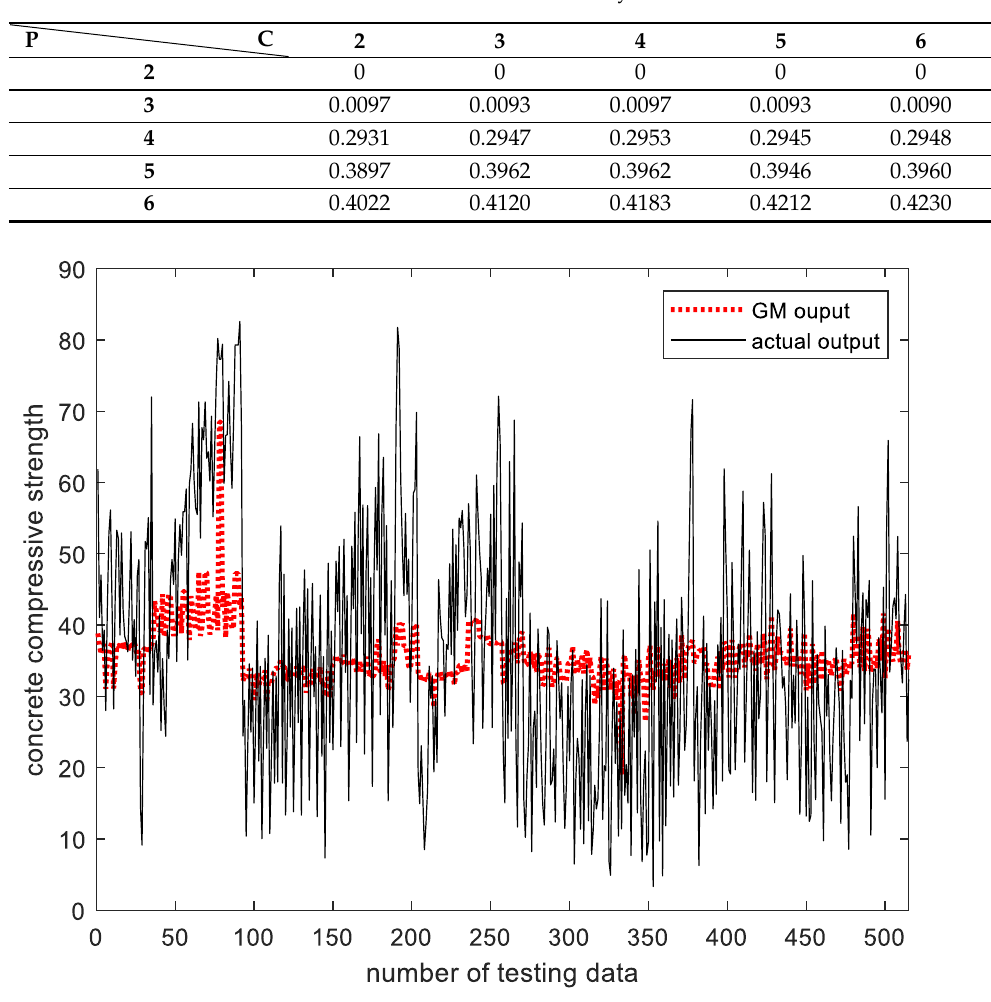
Figure 16. Comparison of the output value of the existing GM with the actual output value (context is created equally, the number of contexts = 6, the number of clusters =